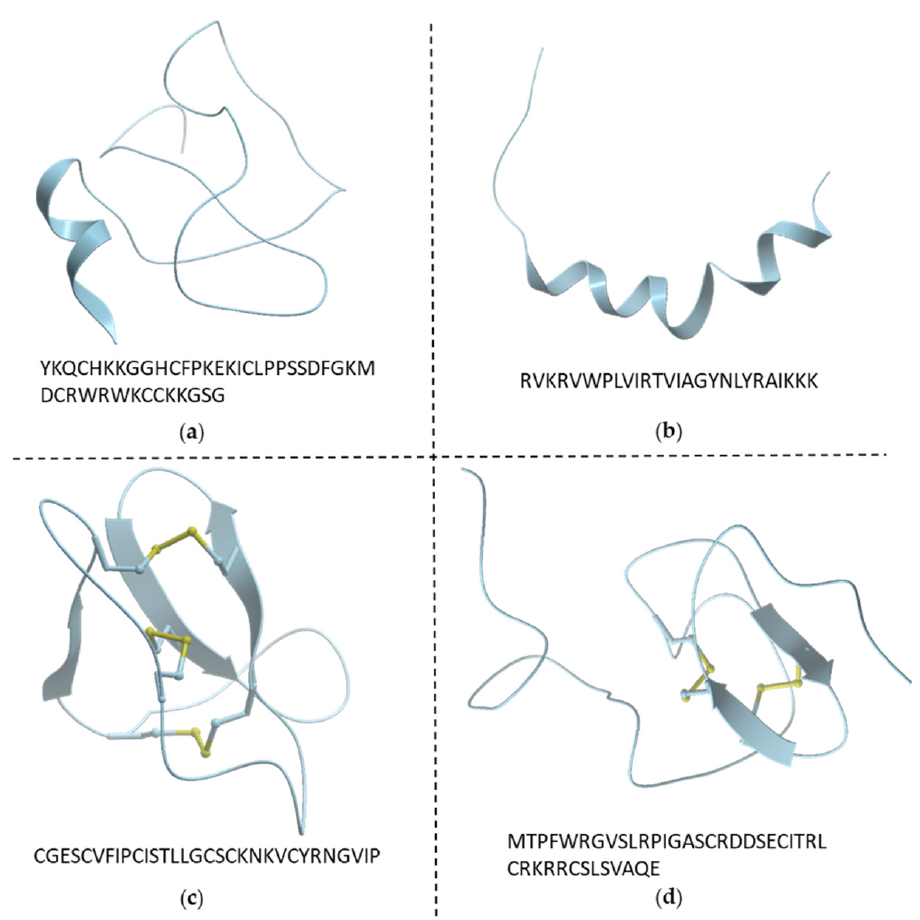
Figure 1. Overview of the variety of 3D AMP structures. ( a ) Crotamine from PDB code 1Z99; ( b ) fowlcidin from PDB code 2AMN; ( c ) circullin B from PDB code 2ERI; ( d ) LEAP-2 from PDB code 2L1Q. Yellow bonds represent disulfide bridges.